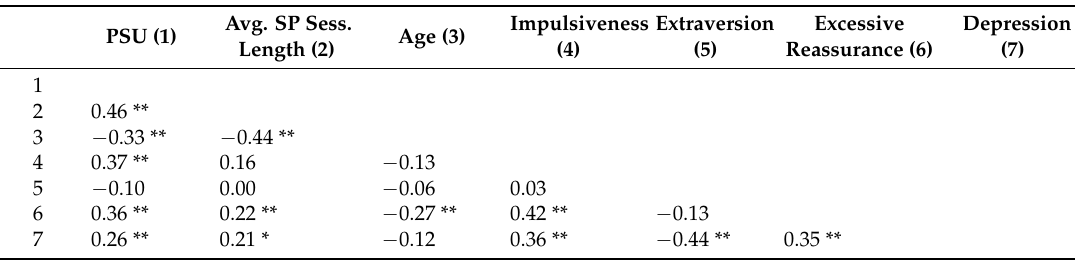
Table 3. Correlations between the study variables.